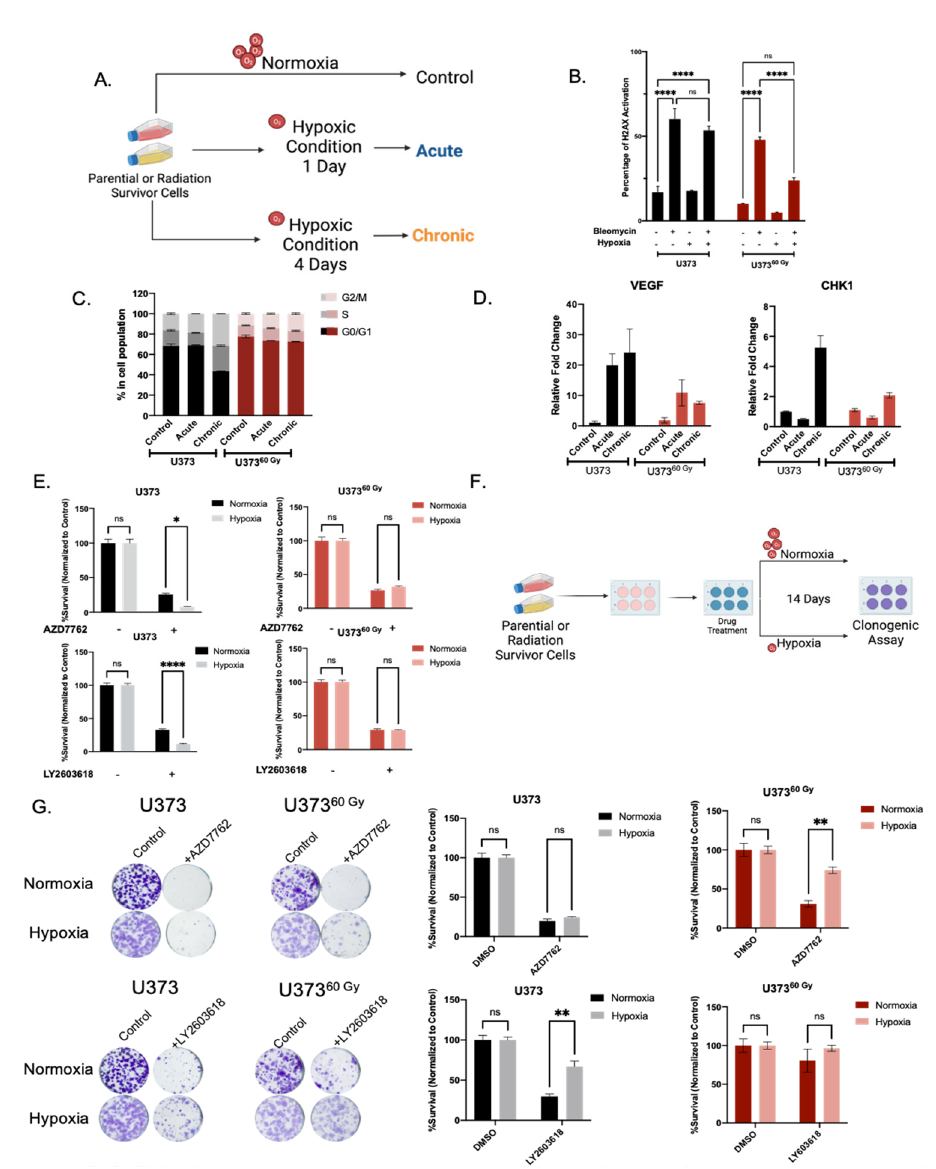
Figure 6. IR-Surv cells have poor DDRi response in hypoxic conditions. ( A ) Schematic representation of experimental flow in hypoxic conditions (generated by Biorender.com). ( B ) Assessment of H2AX activation in combination treatment of hypoxia and Bleomycin. ( C ) Cell Cycle distribution of naïve and IR-Surv cells in normoxia and hypoxia. ( D ) Gene expression levels of CHK1 and VEGF upon culturing in acute and chronic hypoxia. ( E ) Cell viability differences upon treatment of CHK1 inhibitor AZD7762 and LY2603618 in normoxia and hypoxia, treatments were performed for 7 days. ( F ) Schematic representation of experimental setup for colony formation assay in long-term hypoxia. ( G ) Representative clonogenic assay images and quantification of U373 and U373 60 Gy cells upon treatment of CHK1 inhibitor AZD7762 and LY2603618 in normoxia and hypoxia, for 14 days. (ns denote not significant, for p -values, *, ** and **** denote p < 0.05, p < 0.01, p < 0.0001, respectively, two-way ANOVA).